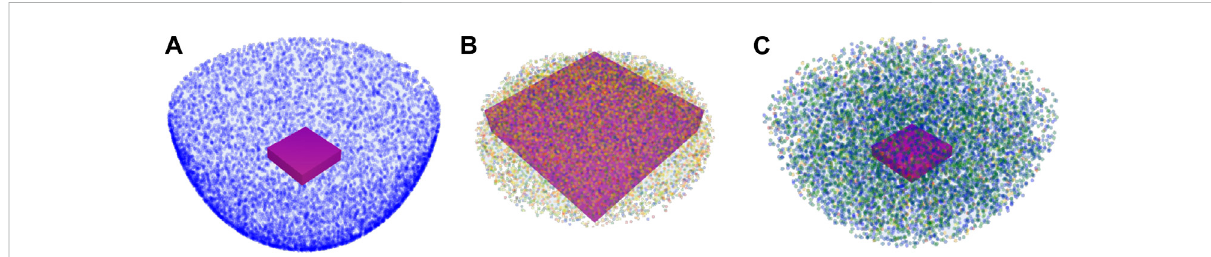
FIGURE 11 Illustrativecomparisonbetweenthesurgical capabilitymapsproposedintheworkofLohmannandKonietschke(2012),Zhangetal.(2021),and RASSCMAP. The task poses are considered within the surgical training pad highlighted as a purple cuboid. (A) Lohmann and Konietschke (2012) representedtheoutlineofthereachableworkspaceindependentofthetask.Themapdoesnotencodeanydexteritydata,andbluevoxelsrepresent reachable voxels. (B) Zhang et al. (2021) used a task-based map, where different colors imply different manipulability indexes of the robot end- effector. However, it does not encode the orientation of the surgical instrument. (C) RASSCMAP where different colors indicate different manipulability indices, while also considering the orientation of the surgical instrument. The map is task independent and provides the complete reachable workspace for the